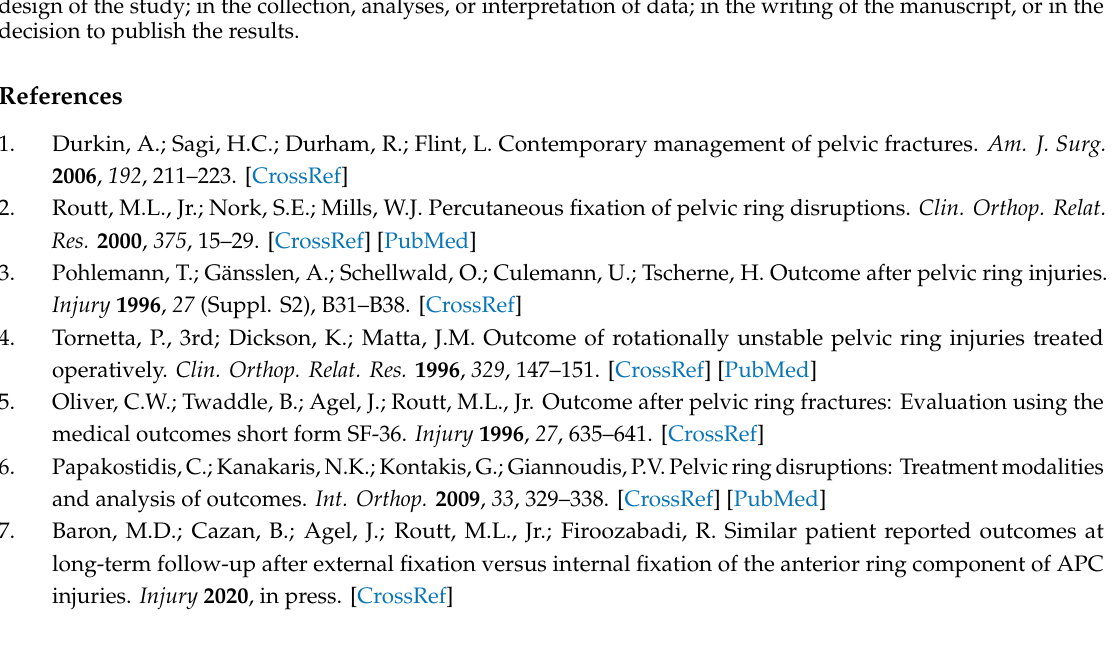
Table S1: Italian version of the Majeed questionnaire, Table S2: Italian version of the Majeed questionnaire. Author Contributions: C.B. and S.B. contributed equally to this